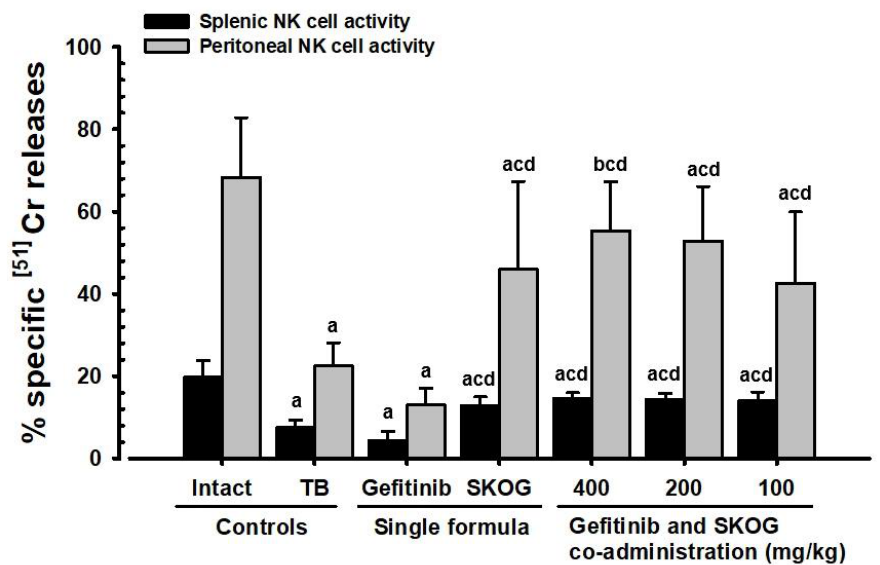
Figure 6. NK cell activity changes in NCI-H520 tumor cell xenograft mice. AR = Adenophorae Radix; KOG = Kyeongokgo ; SKOG = sasam-Kyeongokgo ; TB = tumor-bearing; NK = natural killer (macrophage). a p < 0.01 and b p < 0.05 versus intact control, assessed by the Mann–Whitney U test; c p < 0.01 versus TB control, assessed by the Mann–Whitney U test; d p < 0.01 versus gefitinib-single-formula-treated rodents, assessed by the Mann – Whitney U test.